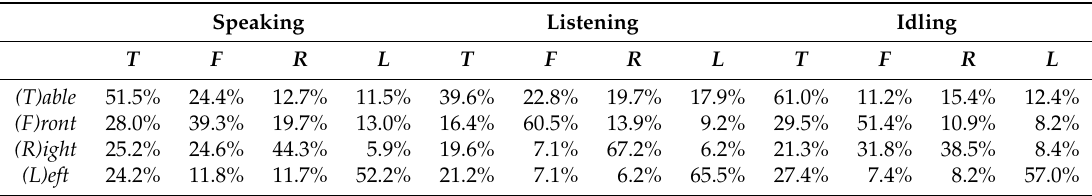
Table 5. Confusion matrices of the proposed attention target prediction models in speaking, listening, and idling situations, respectively: the rows are actual classes and the columns are the predicted